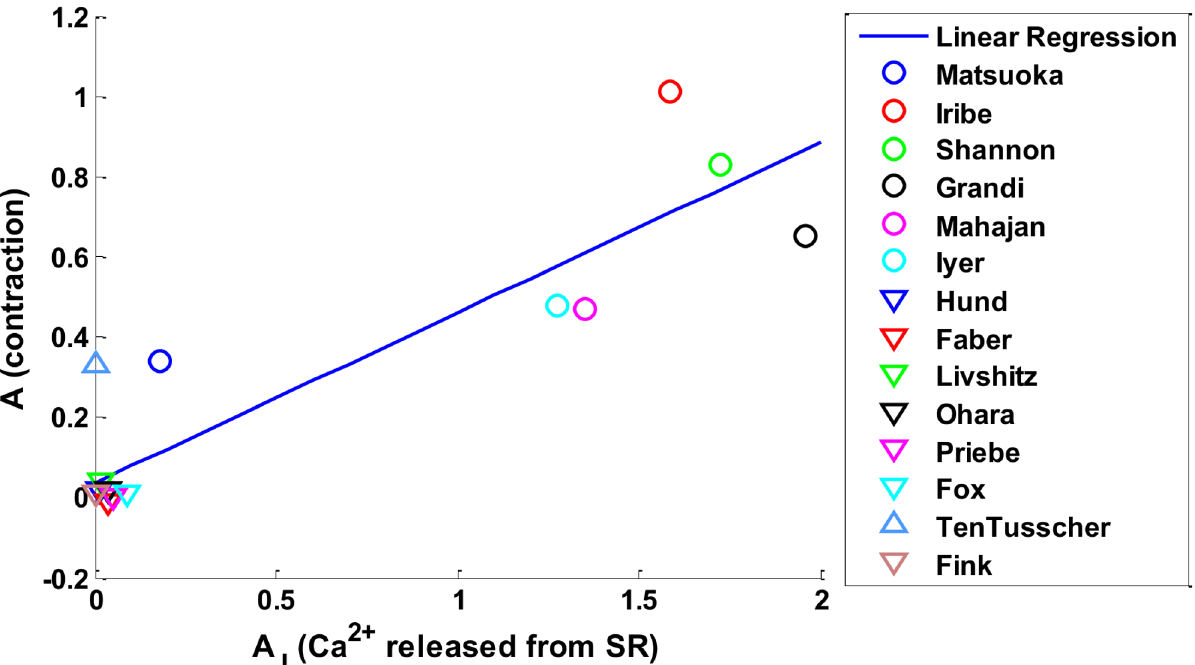
Fig 11. Correlation between the potentiation in Jrel and contractile strength. The Postextrasystolic Potentiation Curves (PESPC) amplitude of contractile strength ( A ) vs that of calcium released from SR ( A J